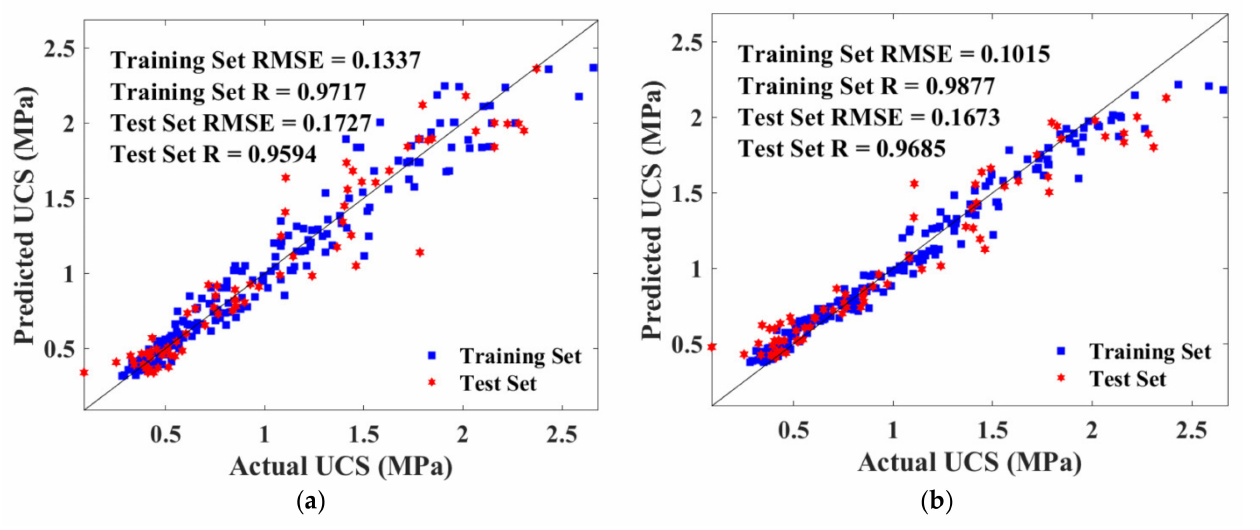
Figure 16. Scatter plot of predicted and actual UCS of training and test sets: ( a ) BAS-BPNN model; ( b ) BAS-RF